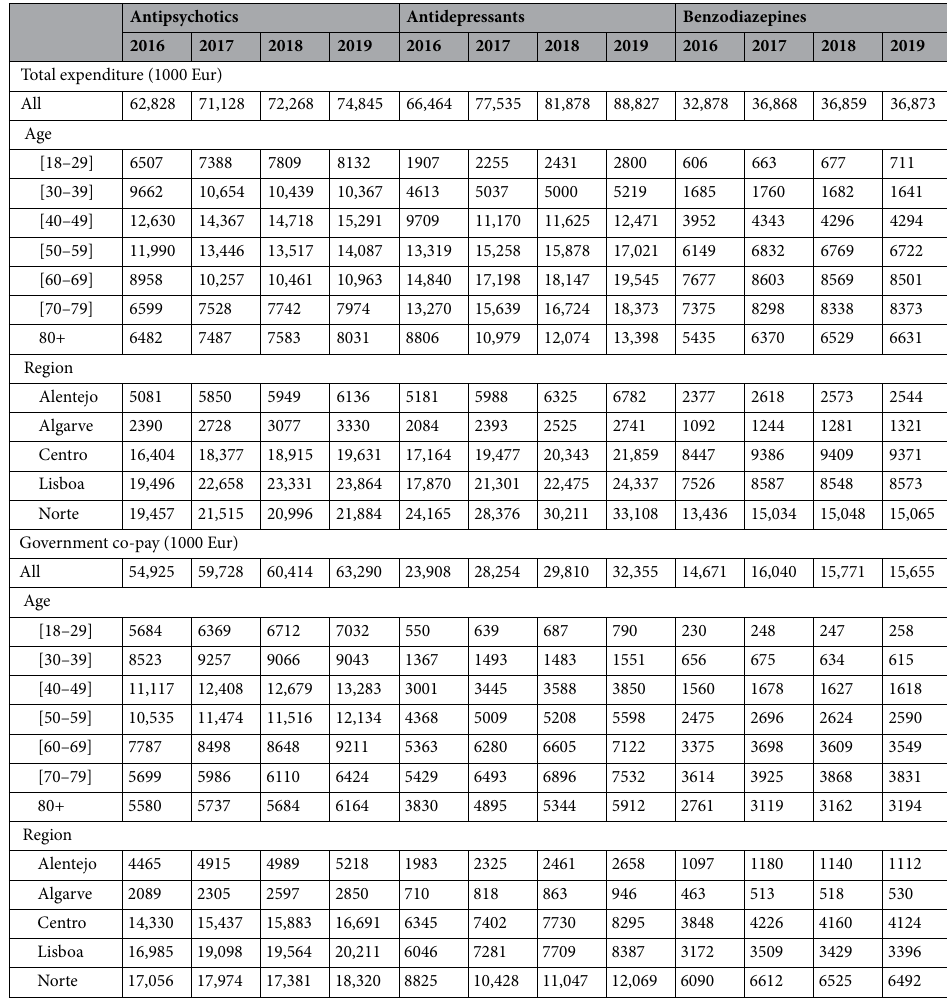
Table 4. Total expenditure (kEur) and governmental co-payment (kEur) with psychotropic